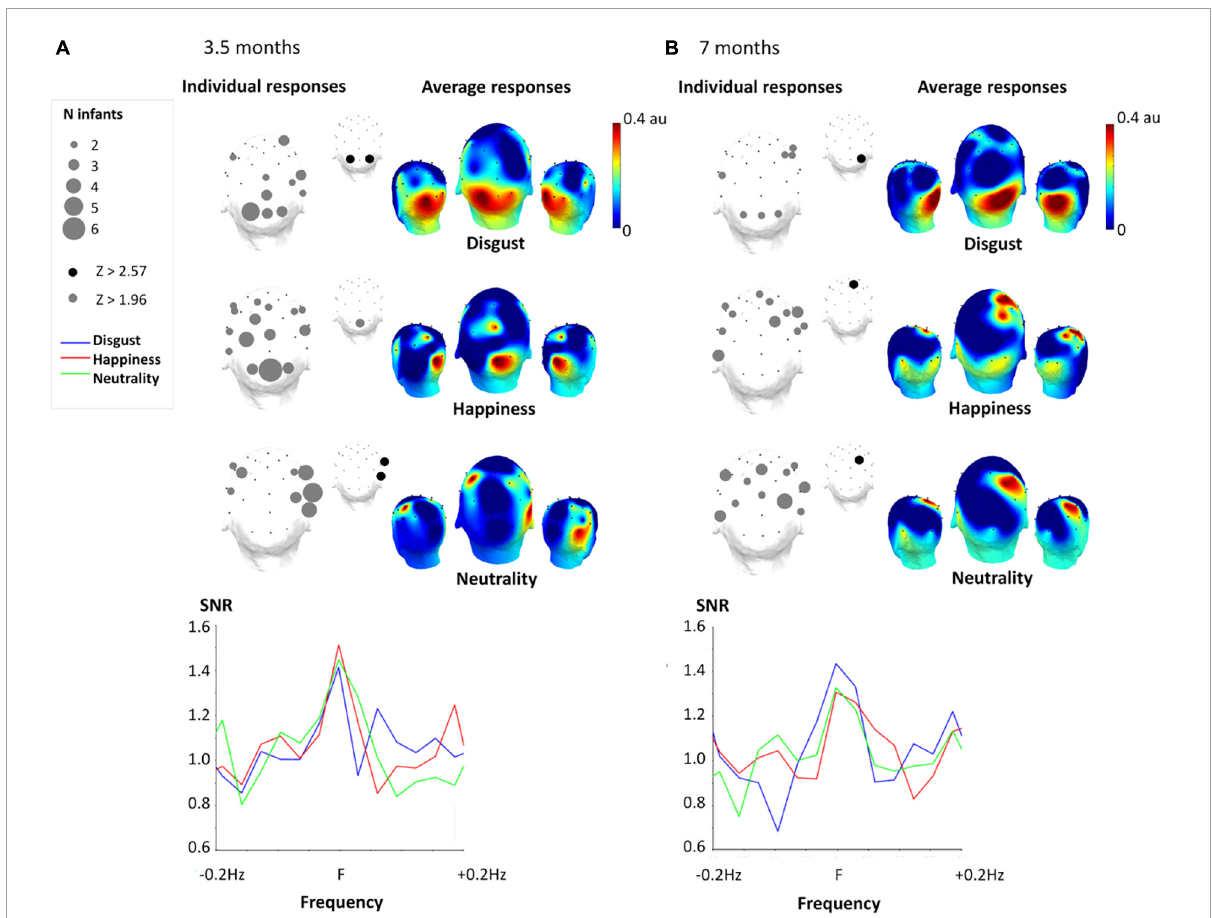
FIGURE2 Expression-change response for the three facial expressions at 3.5 months (A) and 7 months (B) . Left part. Topographical representation (superior view) of significant individual responses. For each electrode, the number of infants with a significant response ( Z > 1.96, p < 0.05) is represented by circle size when at least two individual responses were significant. The smaller topographical map also indicates significant electrodes at group level (gray: Z > 1.96, p < 0.05; black: Z > 2.57, p < 0.01). Right part. 3D topographical color maps (superior view) of the expression-change response (normalized noise-corrected amplitude in arbitrary units) for each expression condition. Bottom part. Signal-to-noise ratio (SNR) of the expression-change response and surrounding frequencies ( ± 0.2 Hz, i.e., ± 6 bins) averaged across significant electrodes for each expression